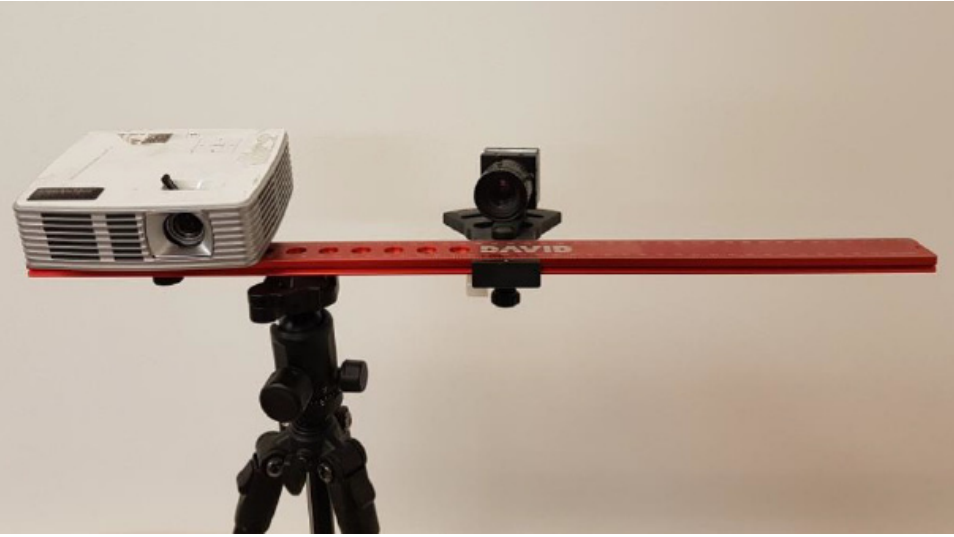
Figure 7. Three-dimensional (3D) scanning assembly.